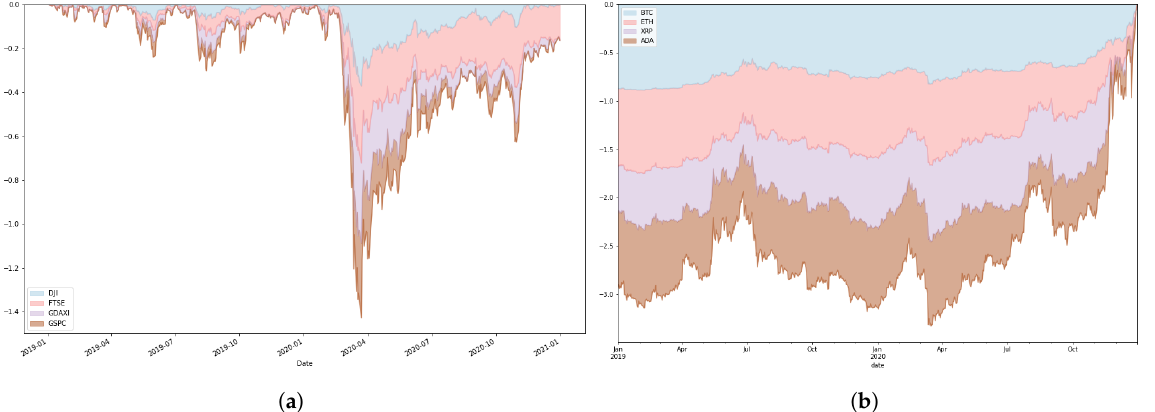
Figure 3. Financial Market’s drawdown during January 2019–December 2020. ( a ) Stock market returns drawdown. ( b ) Crypto market returns